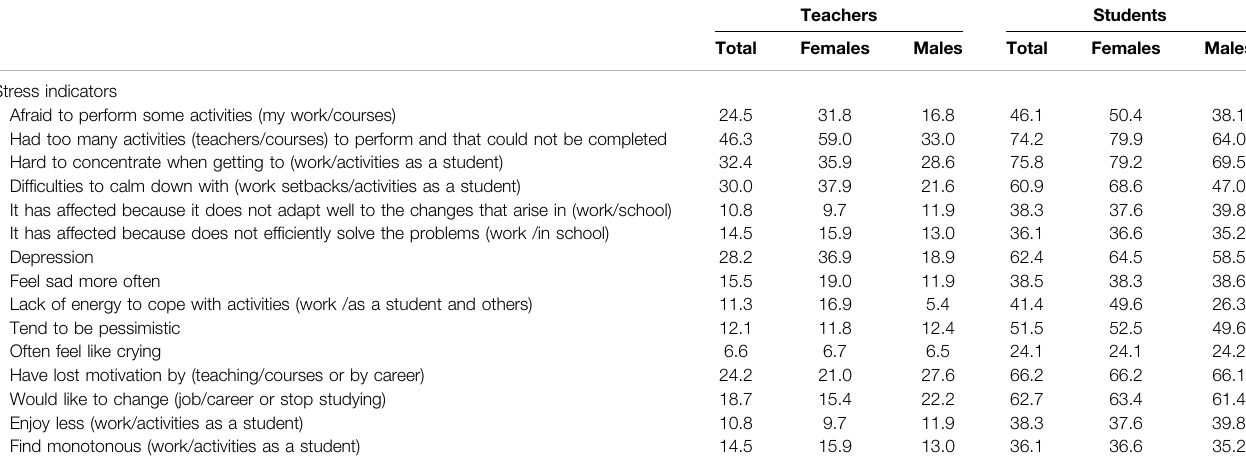
TABLE 6 | Stress and depression indicators among teachers and students derived from the change in teaching